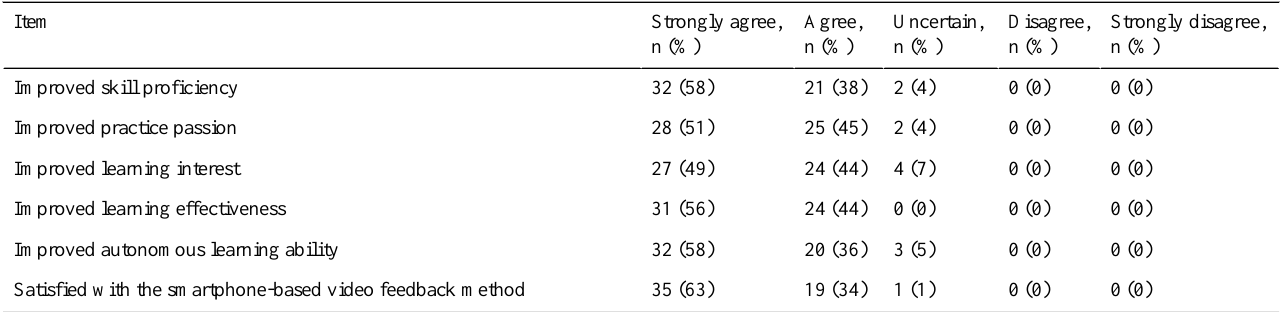
Table 4. Student evaluations of video feedback in the video group